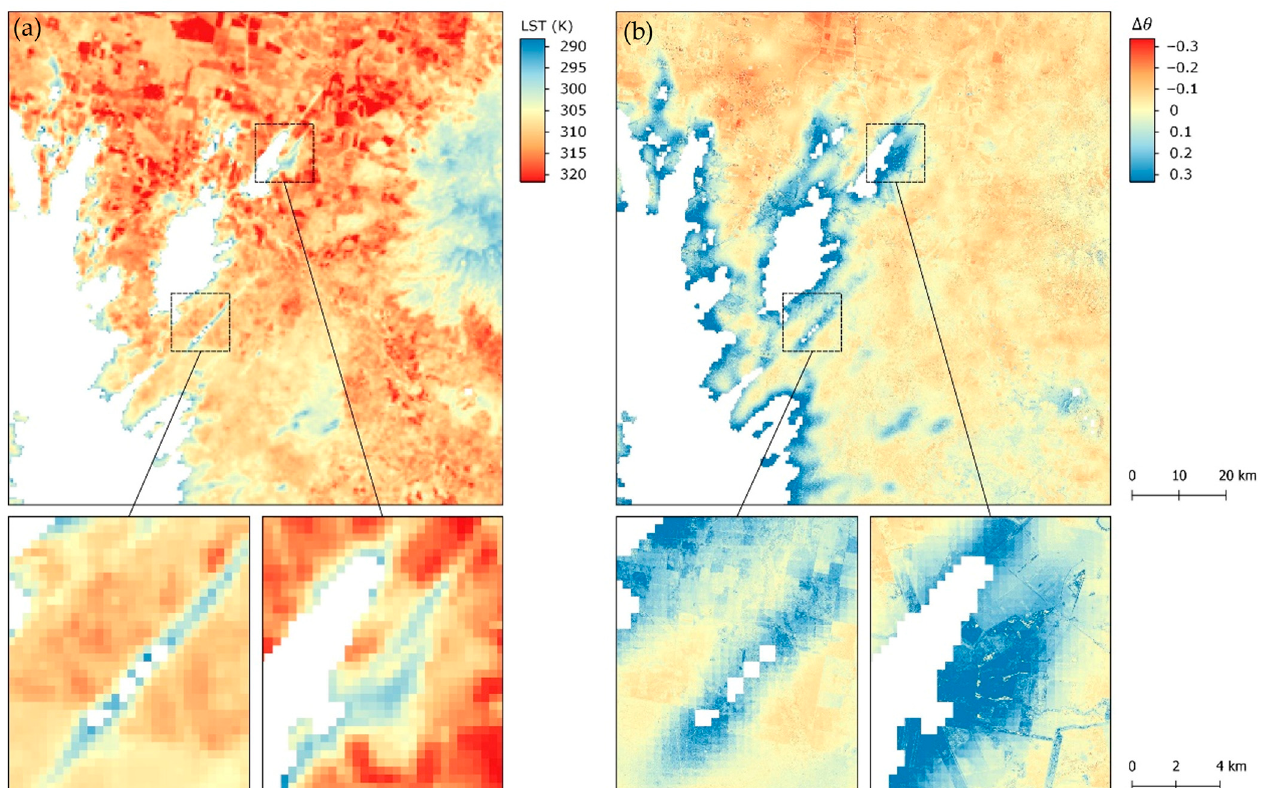
Figure 11. Comparison between cloud-masked VIIRS-based LST data ( a ) and the difference between the high-resolution soil moisture data ( b ) for the 4th of November 2020. White parts of the image are masked using VIIRS’ standard cloud mask. At the edges of this cloud mask, significantly lower LST values are visible, presumably caused by unmasked clouds or cloud shadows, negatively impacting the performance of the soil moisture change product for downscaling precipitation data.